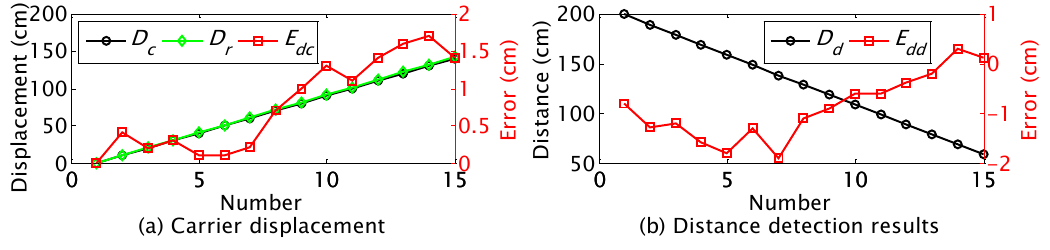
Figure 17. Results of dynamic cooperation for distance